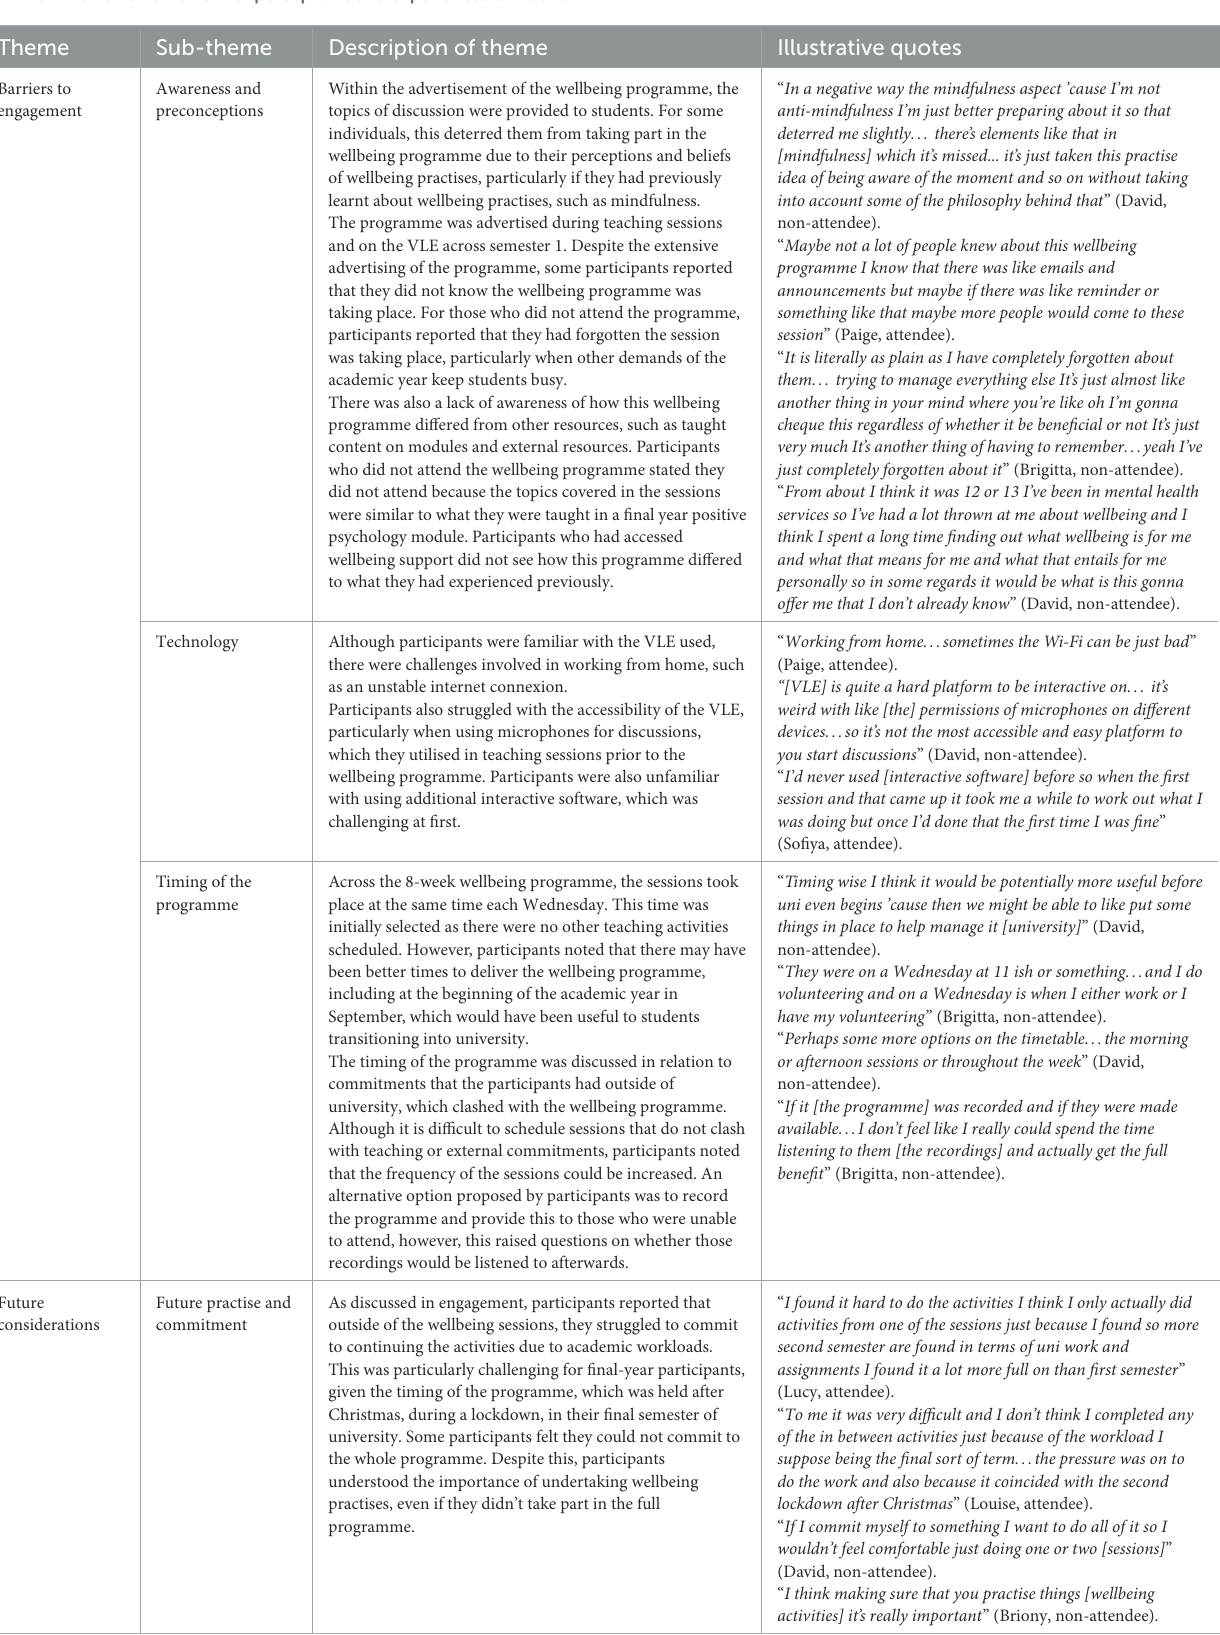
TABLE 5 Thematic framework of perceptions and experiences of